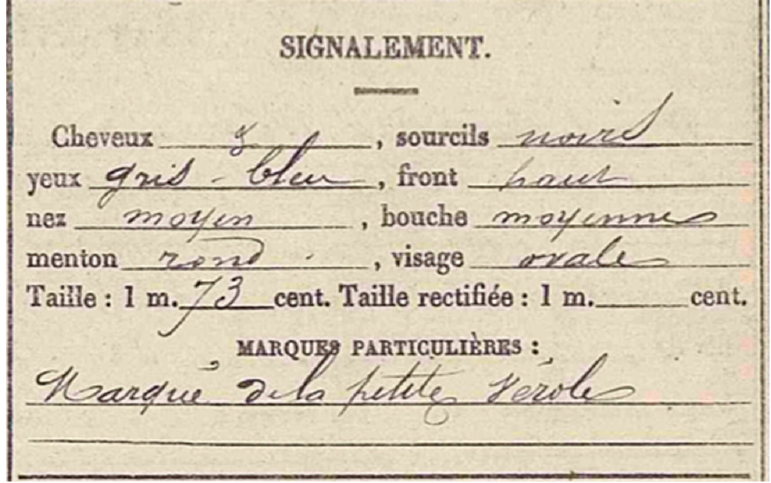
Figure 1. French register extract. Stature is mentioned as 1.73 m. © Departmental archives from Seine-et-Marne.